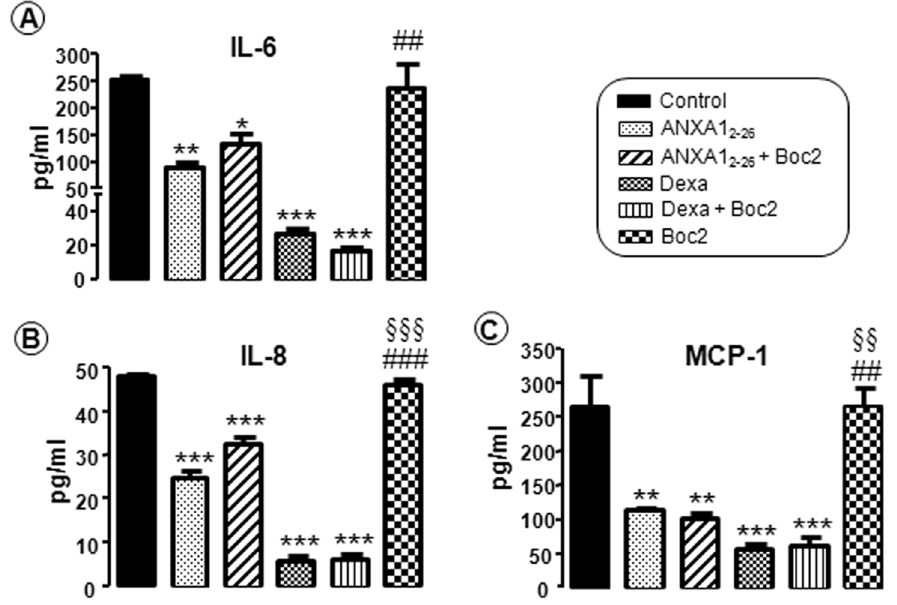
Fig. 5. Effect of the peptide ANXA1 2–26 on proinflammatory cytokine expression. Low expression of IL-6 ( A ), IL-8 ( B ) and MCP-1 ( C ) after treatment with ANXA1 2–26 and dexamethasone. Hep-2 cells were seeded in MEM-Earle medium at a density of 2 6 10 6 cells in 75-cm 2 culture flasks, and then were incubated with serum- free medium 24 hours prior to the addition of ANXA1 2–26 (1 m M), ANXA1 2–26 (1 m M) + Boc2 (10 m M), Dexa (0.01 m M), Dexa (0.01 m M) + Boc2 (10 m M) or Boc2 (10 m M) alone. All of the experiments were performed in triplicate to confirm the results. Data are expressed as the mean ¡ SEM of the analyte concentration (pg/mL), determined using MAGPIX xPONENT software . * P , 0.05, ** P , 0.01 and *** P , 0.001 vs. control, ## P , 0.01 and ### P , 0.001 vs. ANXA1 2–26 , 11 P , 0.01 and 111 P , 0.001 vs. ANXA1 2–26 +